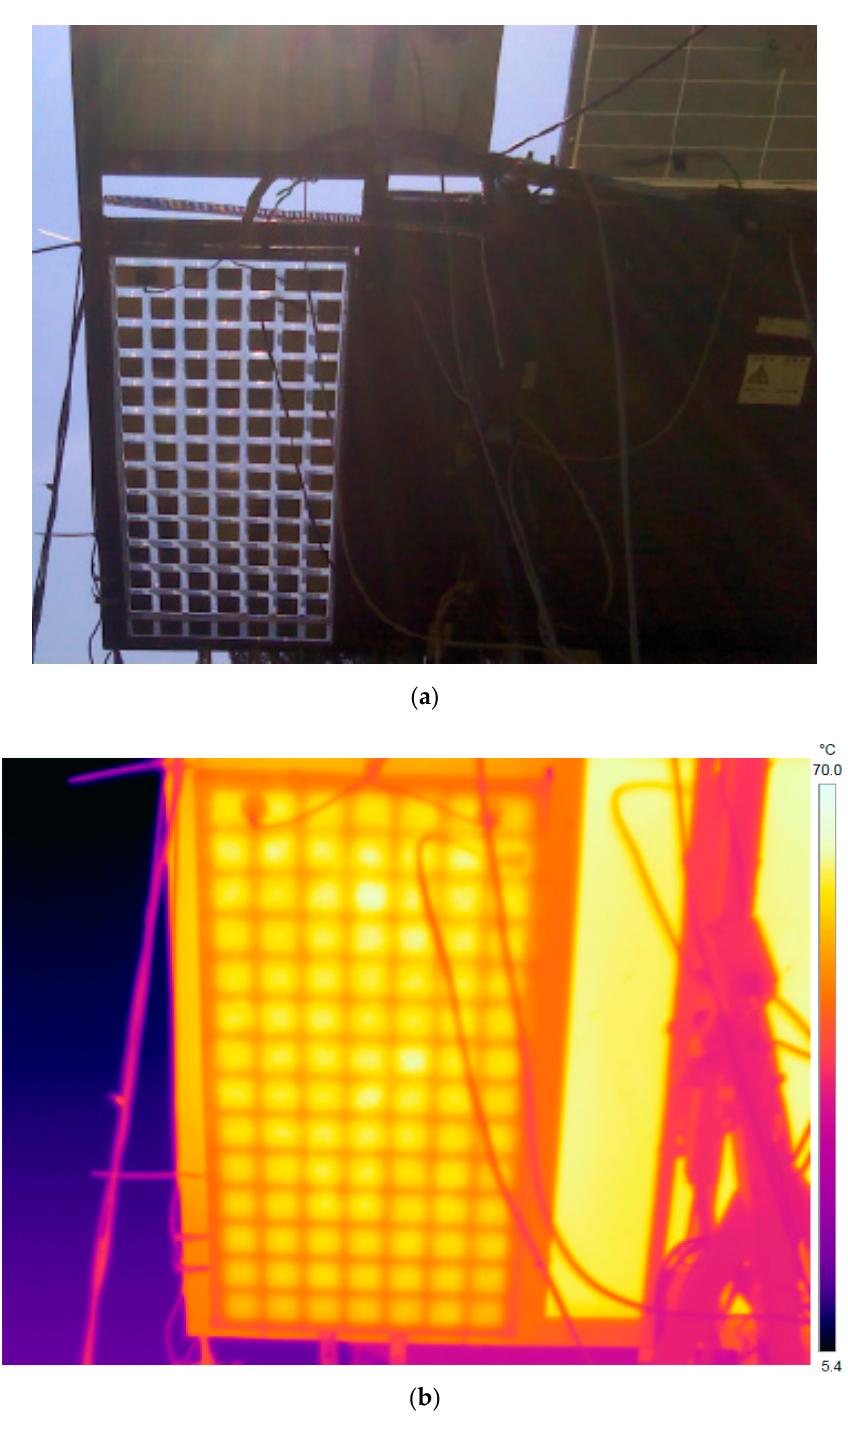
Figure 7. The back of CPV module ‘A’ in visible radiation ( a ) and in infrared radiation ( b ).